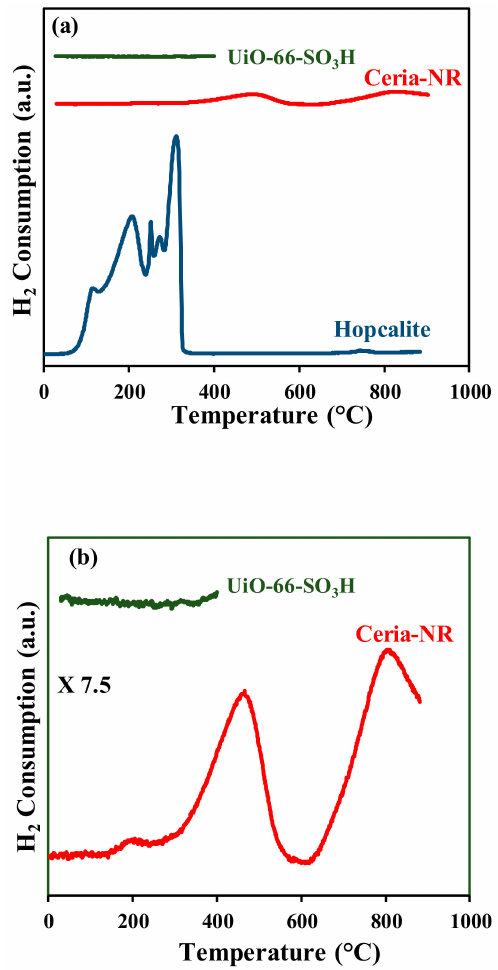
Figure 3. ( a ) H 2 -TPR curves of the samples; ( b ) zoom of the H 2 -TPR